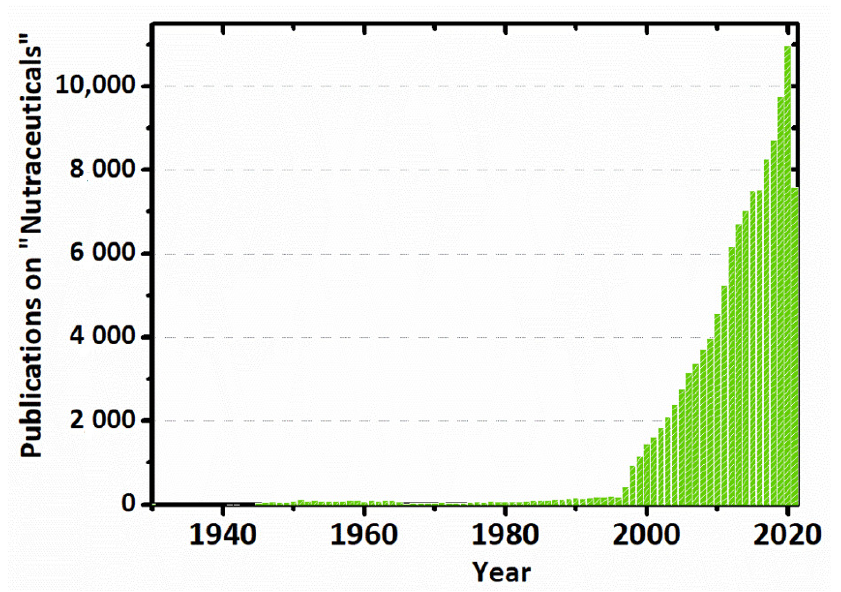
Figure 2. Graph representing the number of research papers (found in PubMed) published on nutraceuticals per year.